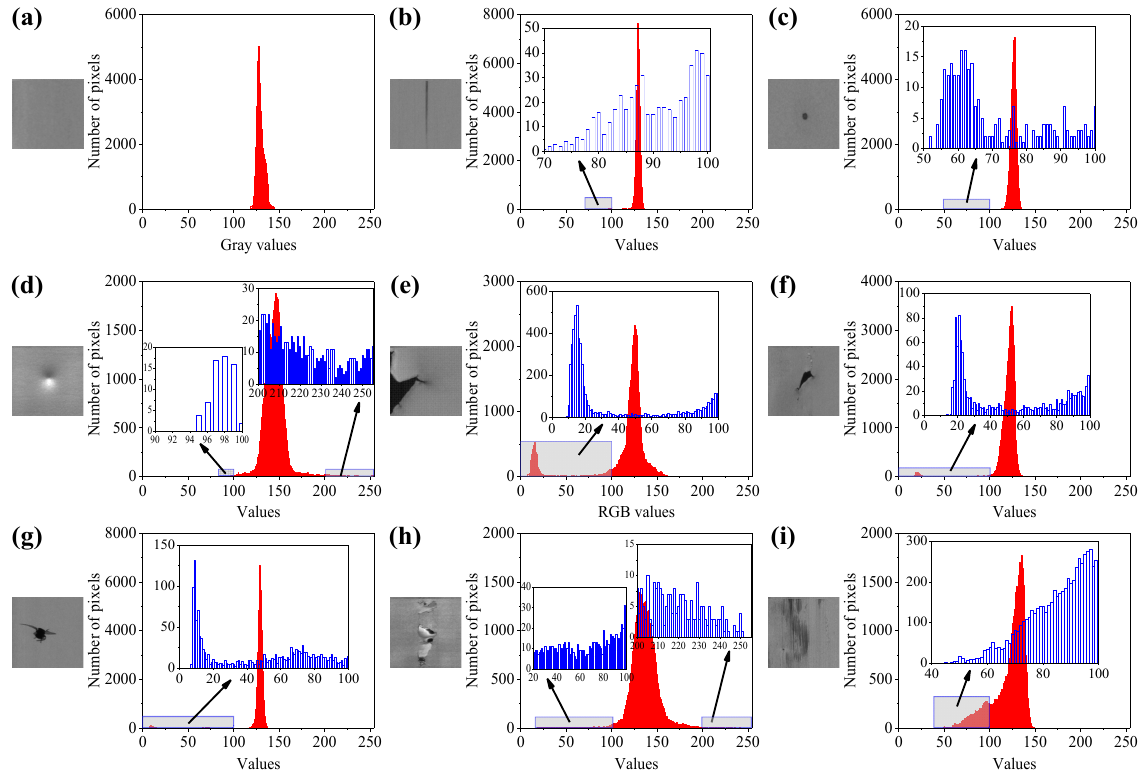
Figure 4. Statistical results of gray value distribution of perfect and defect images: ( a ) perfect image, ( b ) LM, ( c ) BS, ( d ) CP, ( e ) EC, ( f ) Ho, ( g ) IS, ( h ) Pe, and ( i ) Sm.